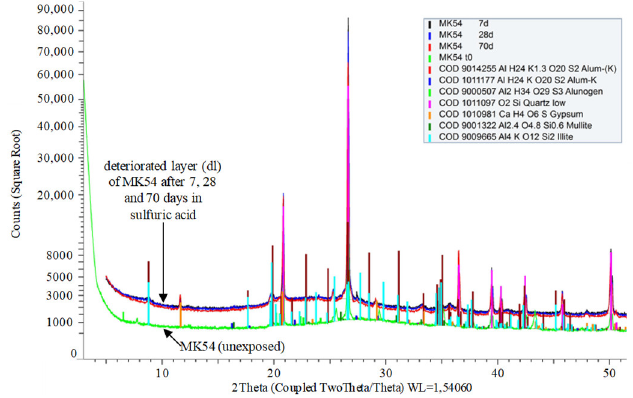
Figure 11. Characteristic parts of XRD patterns of unexposed geopolymer MK54 and deteriorated layers (dl) of MK54 after 7, 28, and 70 days of exposure to sulfuric acid.